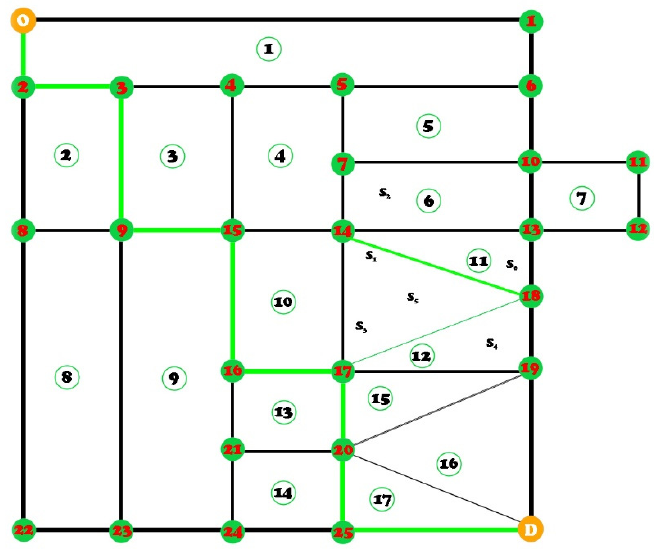
Figure 1. Representative diagram of a structure that optimizes the transport of large tonnage. The delimitation of the point of origin and the presentation of the destination point D, but also the division of the restricted areas into approximately 17 zones with 27 nodes capable of covering 5 km 2 .